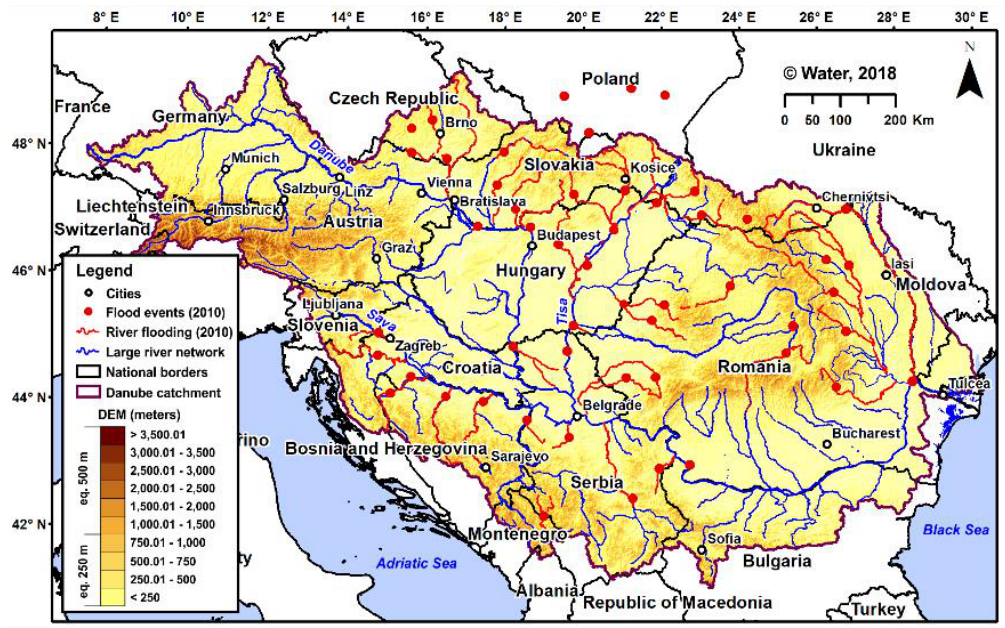
Figure 1. Major floods events within the Danube basin and the surrounding areas that occurred from May to June 2010.